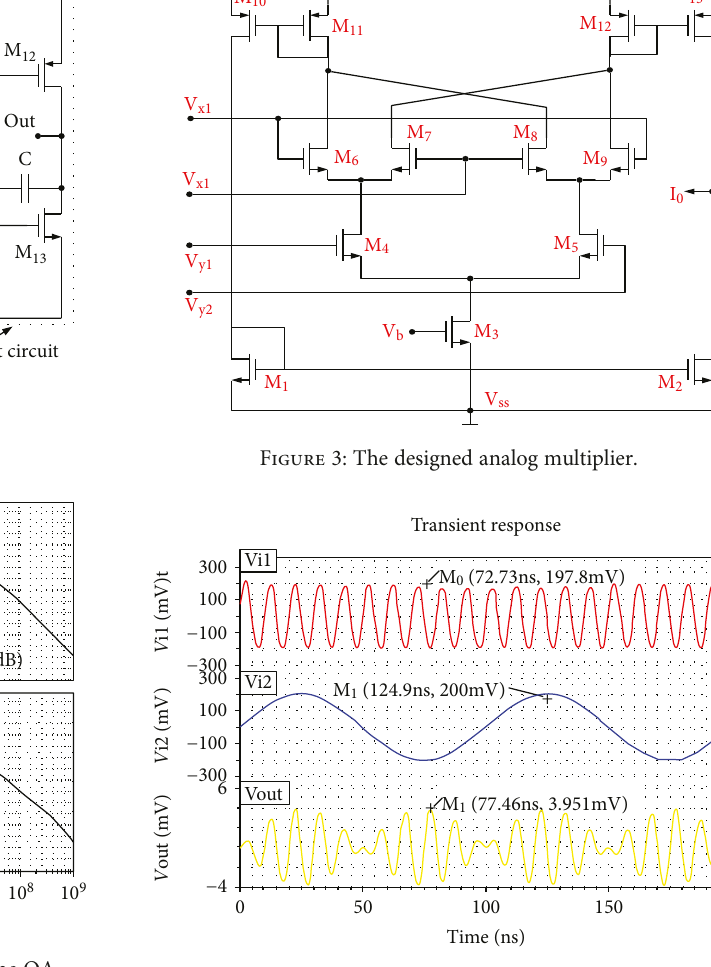
Figure 4: The transient response of the analog